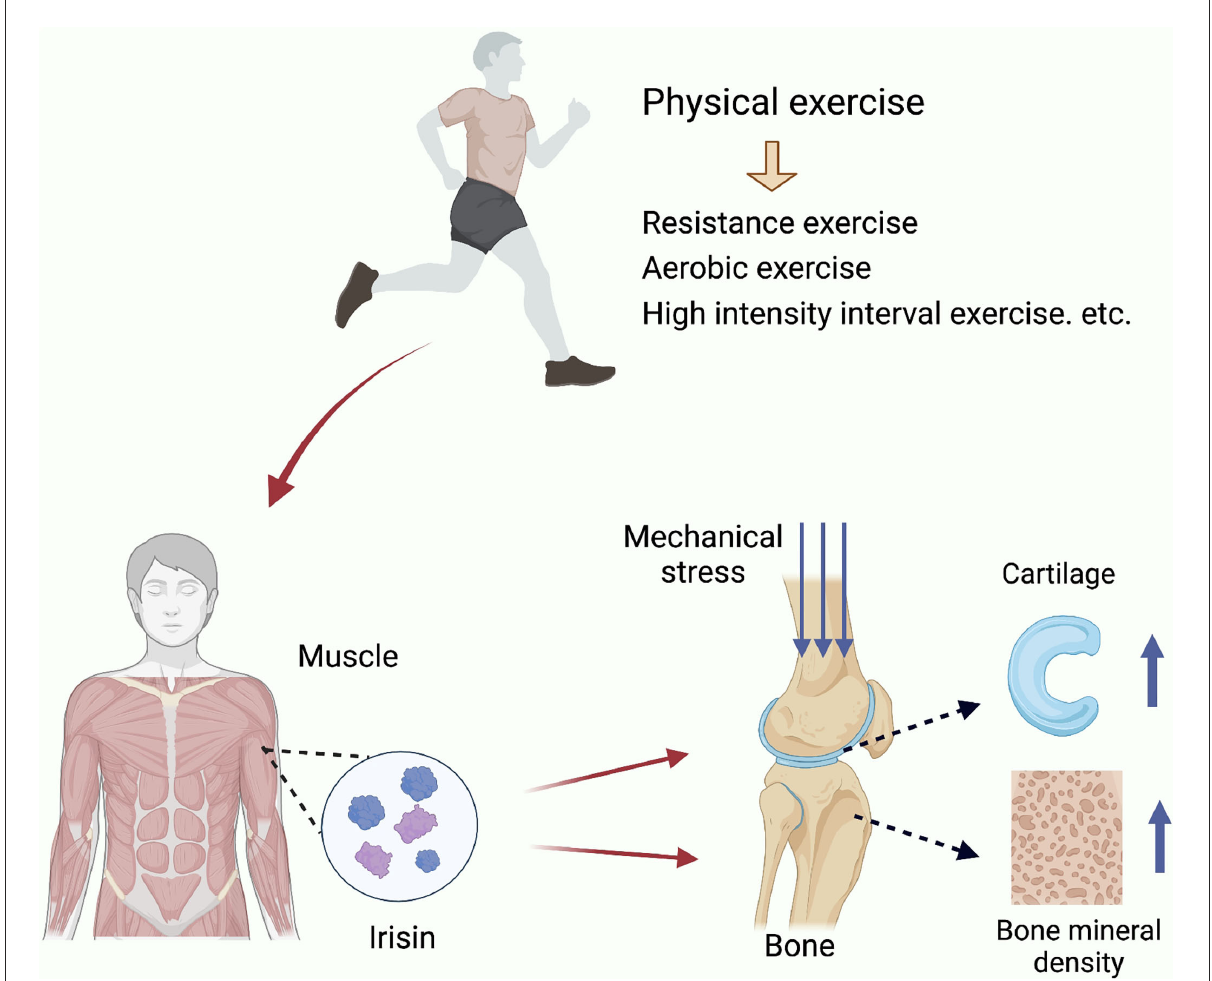
FIGURE1 Exercise inducted effects of Iris and its regulation in OA. Irisin is secreted by skeletal muscle in response to exercise stimulation and increases bone density, enhances the mechanical support of cartilage by subchondral bone, improves cartilage tissue, and promotes chondrocyte